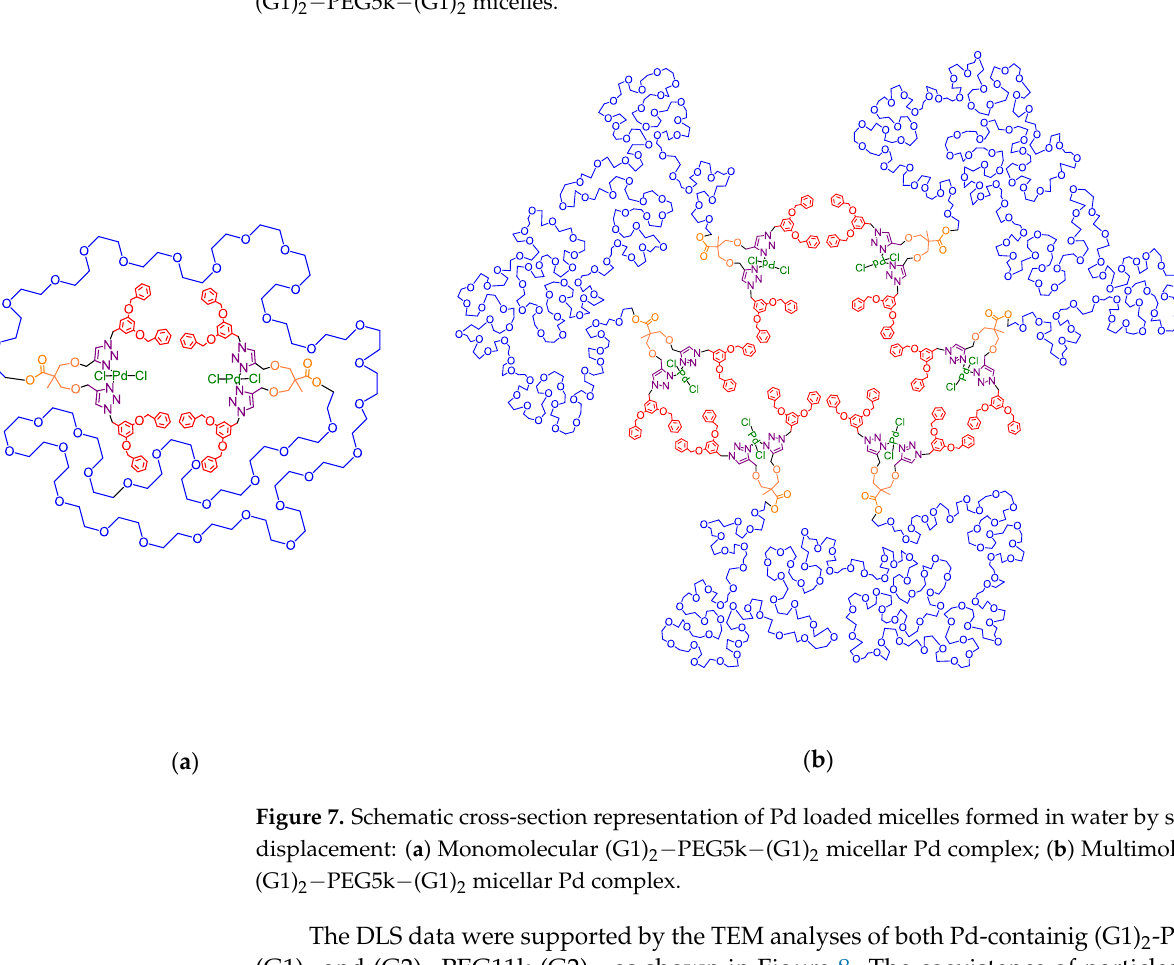
Figure 6. Aqueous solutions of PdCl 2 (PhCN) 2 : ( a ) without (G1) 2 −PEG5k−(G1) 2 micelles; ( b ) with (G1) 2 −PEG5k−(G1) 2 micelles.